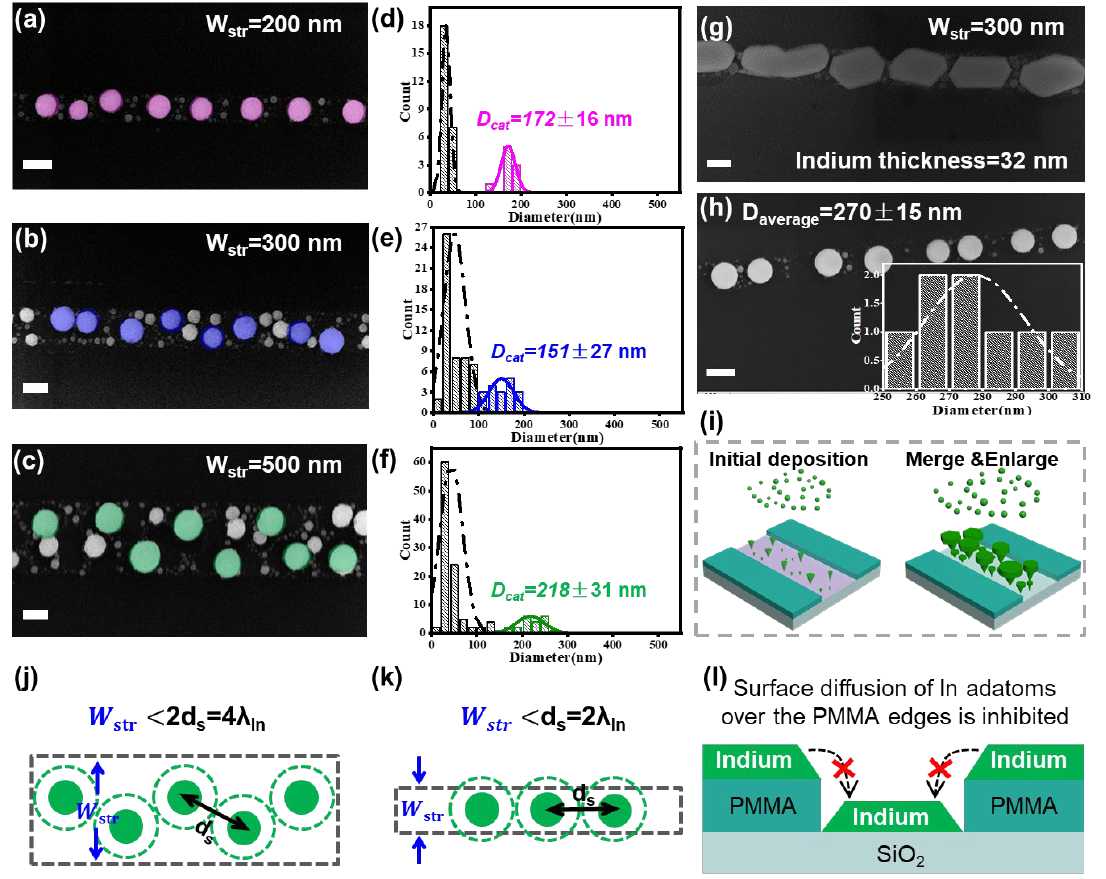
Figure 3. ( a – c ) SEM images of the In droplets formed on the nanostripes with the same In thickness of 16 nm but different W str = 200 nm, 300 nm and 500 nm, with corresponding diameter statistics displayed in ( d – f ). In comparison, the In catalyst formations within a stripe width of 300 nm, with a thicker In thickness of 32 nm, are presented in ( g , h ) for the situations of initial grains and the droplets formed after H 2 plasma treatment. ( i ) depicts schematically the (left) initial In atom nucleation and (right) subsequent merging stages during the thermal evaporation. ( j , k ) illustrate the formation of discrete In nucleation sites and their collection zones, delineated by the dashed circles, within nanostripe widths of W str ~ 3 λ In and W str ~ 2 λ In , respectively. ( l ) illustrates that the surface diffusion of In adatoms over the PMMA pattern edges is very inefficient or inhibited. Scale bars in ( a – c , g , h ) are all for 200 nm.